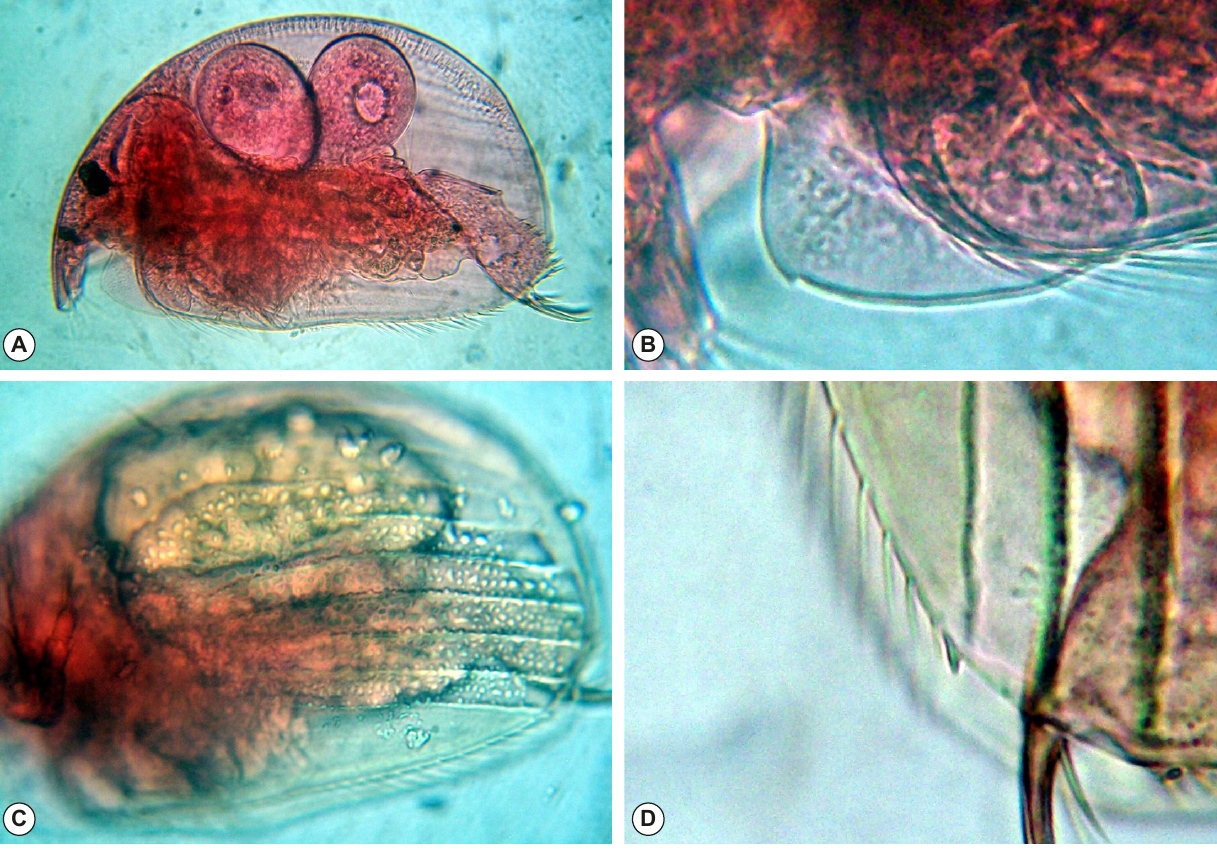
Figure 12. Coronatella